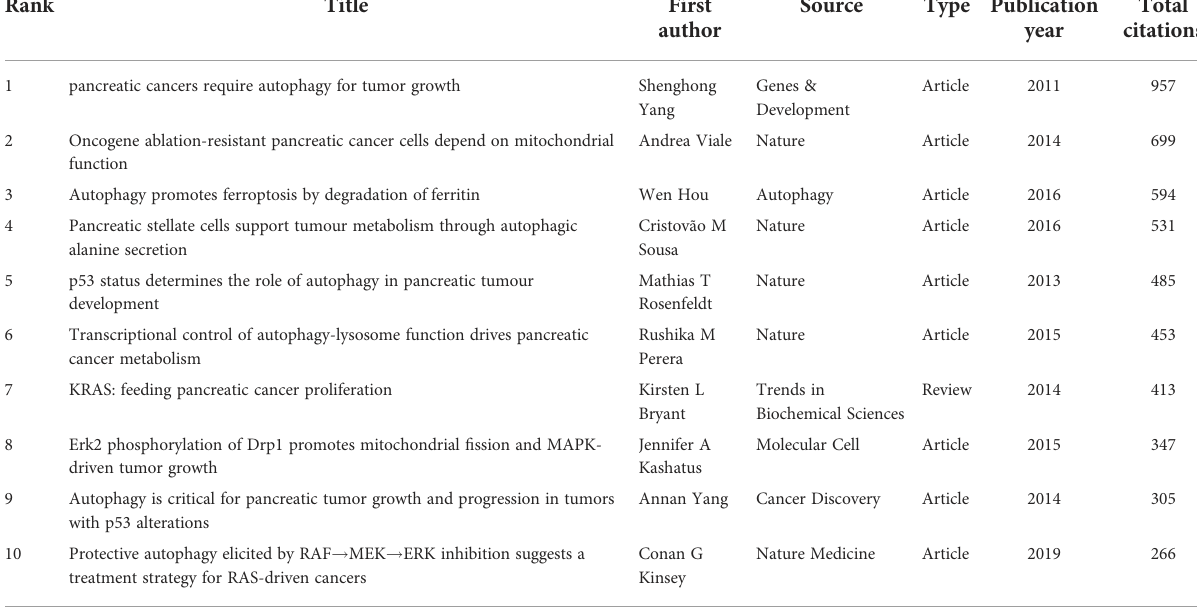
TABLE 6 The most cited papers in the fi eld of autophagy and pancreatic cancer. Rank